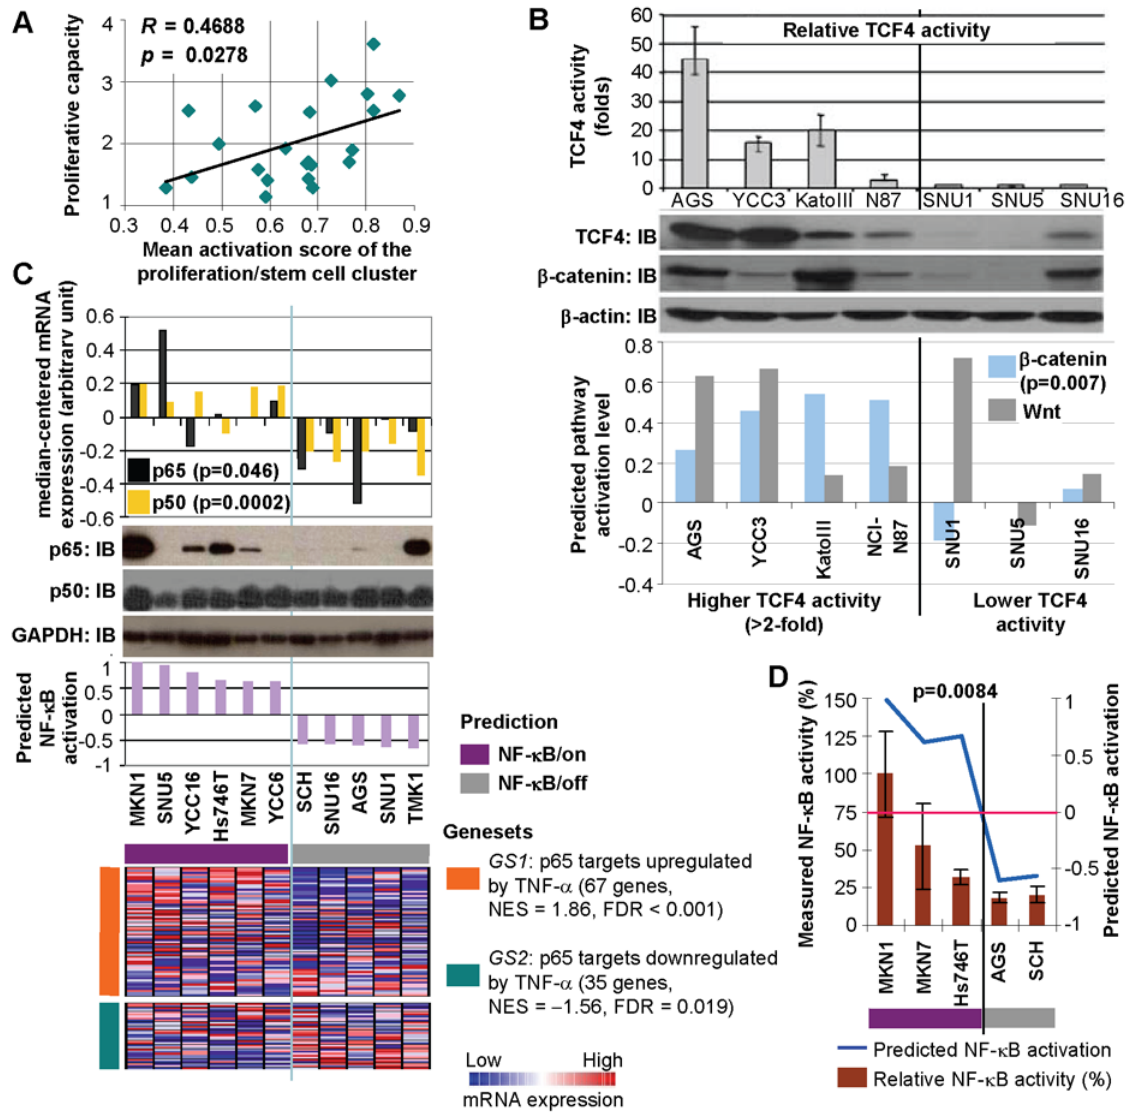
Figure 4. Experimental validation of pathway predictions in gastric cancer cell lines. (A) Experimental validation of proliferation/stem cell pathway predictions. The graph depicts the experimentally measured proliferative capacities of 22 cell lines (y-axis) against the mean proliferation/ stem cell activation scores derived from signatures belonging to the proliferation/stem cell cluster. (B) Experimental validation of Wnt/ b -catenin pathway predictions. The bottom graph shows the predicted activation levels of the Wnt (grey bars) and b -catenin (blue bars) pathways across seven cell lines. Lines predicted to be active exhibit expression of canonical Wnt pathway components b -catenin and TCF4 (aka TCF7L2) (middle immunoblot), and higher TCF4 transcriptional activity (top graph) compared to lines associated with inconsistent or low Wnt/ b -catenin activation scores. Immunoblots were normalized using a b -actin antibody. Parts of this figure were previously presented [50] for a different purpose. (C,D) Experimental validation of NF- k B pathway predictions. (C) The bottom graph shows predicted NF- k B activation levels across 11 cell lines. Lines predicted to be active (‘NF- k B/on’) exhibit significantly higher p65 and p50 mRNA expression levels (topmost graph) and p65 protein expression (immunoblot) relative to lines predicted to be nonactivated (‘NF- k B/off’). All lines exhibit comparable p50 protein expression. Immunoblots were normalized using a GAPDH antibody. Whether p65 target genes are over- or under-expressed in ‘NF- k B/on’ lines compared to ‘NF- k B/off’ lines depends on whether they were up- or downregulated by TNF- a [26], an inducer of NF- k B activation (bottom heatmap). (D) NF- k B activity in cell lines. ‘NF- k B/on’ lines exhibit significantly higher NF- k B transcriptional activity compared to ‘NF- k B/off’ lines. doi:10.1371/journal.pgen.1000676.g004 k B/on’, six GCCLs) or NF- k B-nonactivated (‘NF- k B/off’, five GC cell lines, p65 protein expression was more frequently observed in NF- k B/on GC cell lines compared to NF- k B/off GCCLs) (Figure S2). Increased gene expression of p50 and p65, GC cell lines in terms of nuclear sublocalization, percentages of the NF- k B heterodimer subunits, were observed in NF- k B/on GC cells with staining (either nuclear or cytoplasmic), and staining cell lines compared to NF- k B/off GC cell lines (p = 0.0002 for intensity (Table S5, Figure S3). To determine if NF- k B/on GC p50, p= 0.046 for p65, Figure 4C) and at the protein level p65 cell lines also exhibited differential expression of p65-regulated expression was observed largely in the NF- k B/on lines (Figure 4C). genes compared to NF- k B/off GC cell lines, we combined the list Using immunocytochemistry on formalin fixed paraffin embedded